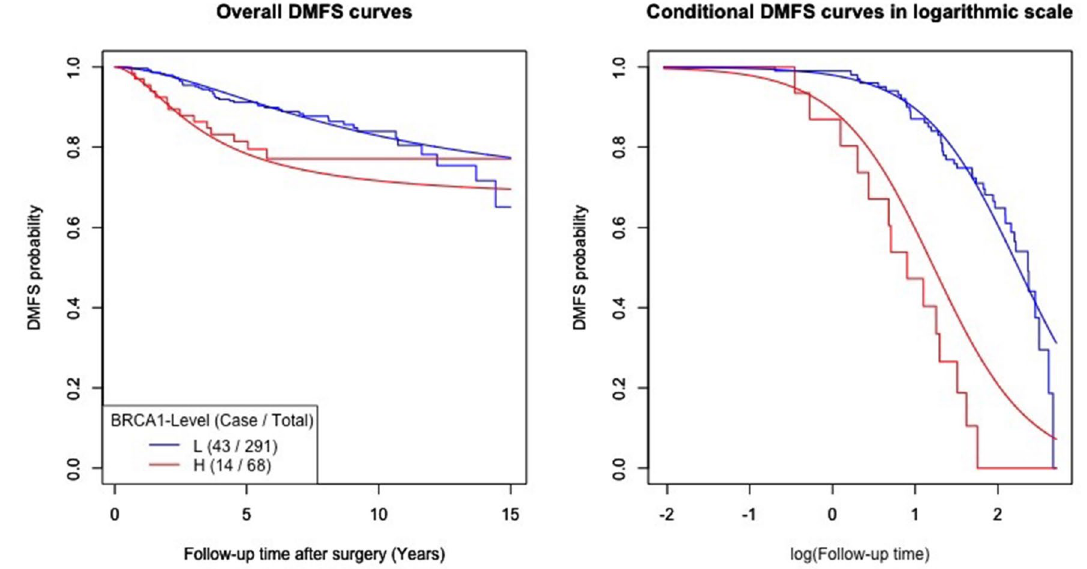
Figure 3. Survival curves fitted by the “Logistic-AFT mixture regression model” at the 8th decile. Kaplan– Meier (step function) and mixture regression (smooth curve) estimators of overall and conditional DMFS curves for the DM onset time after surgery stratified by BRCA1 level defined at the cutoff point 8th decile. The BRCA1 high- and low-expression groups are shown in red and in blue, respectively. P value of likelihood ratio test (P LRT ) was